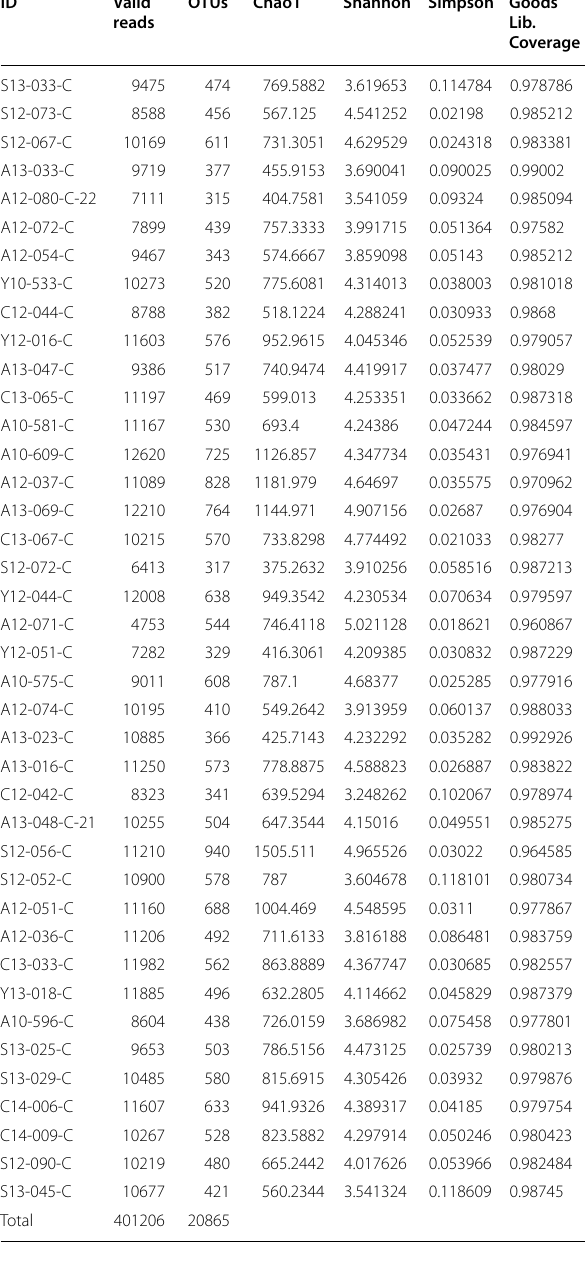
Table 1 Library coverage estimations and sequence diver‑